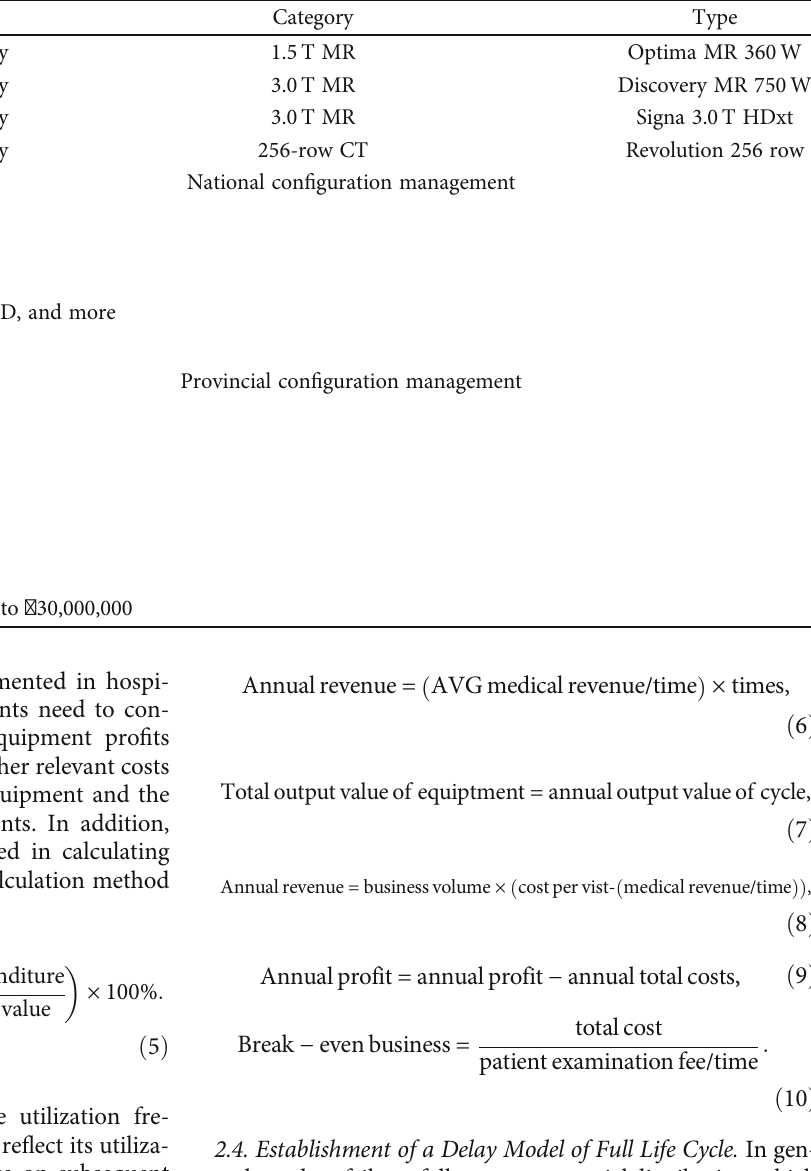
Table 1: Detailed statement of names and classi fi cation of